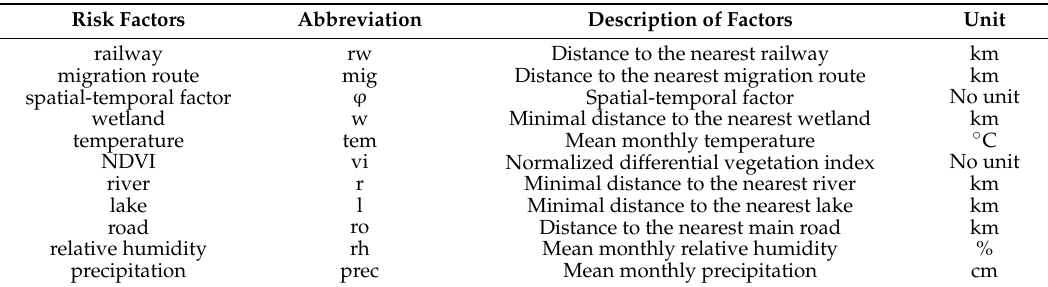
Table 3. Summary of risk factors used in the logistic regression analysis of human infection with avian influenza A(H7N9) virus in China, with abbreviation and unit.